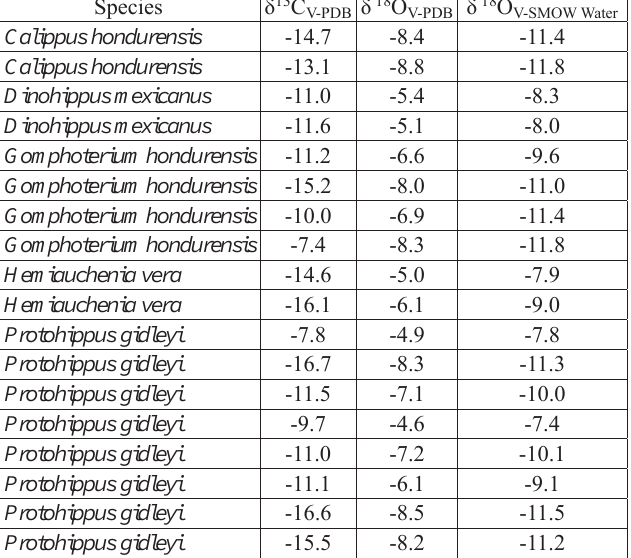
Table 1. Carbon and oxygen isotope values (‰) from dental enamel of fossil herbivorous mammals from the Early–Late Hemphillian of San Gerardo de Limoncito, Costa Rica (after Laurito and Valerio 2016). Species